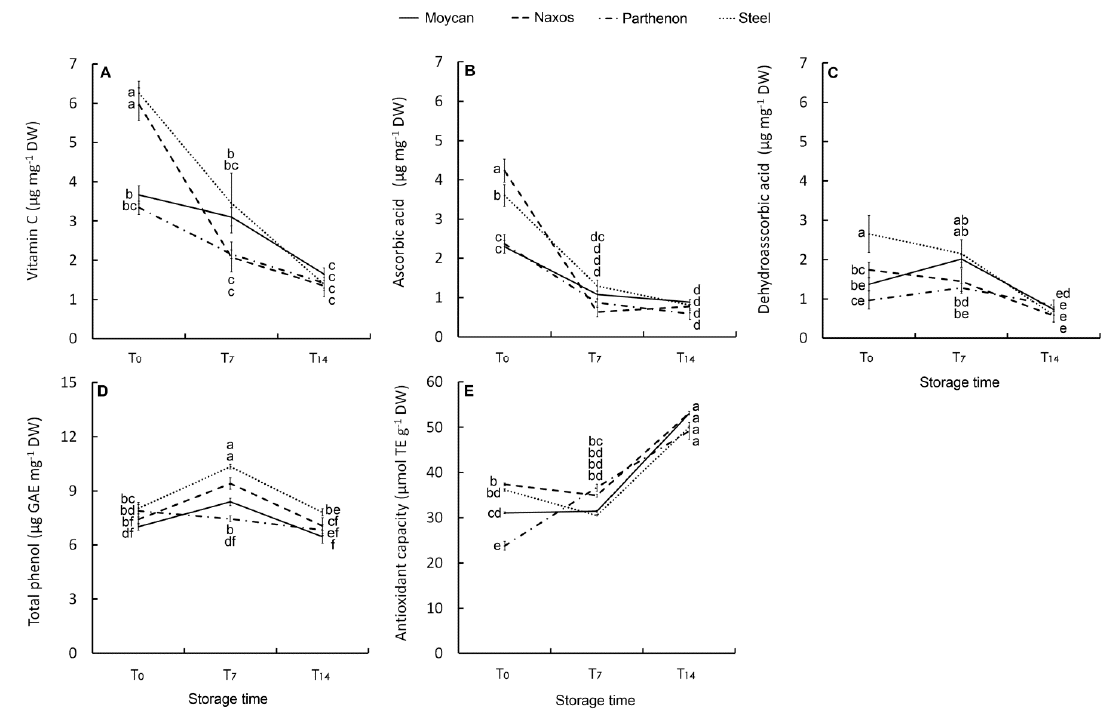
Figure 6. Effect of genotype on vitamin C ( A ), ascorbic acid ( B ), dehydroascorbic acid ( C ), and total phenol concentration ( D ), as well as on antioxidant capacity ( E ) of the raw heads (T 0 ), in 7 days (T 7 ) and 14 days (T 14 ) stored product. Vertical bars (± SE of mean) ( n = 9) with different letters are significantly different according to the Least Significant Difference test ( P = 0.05). GAE = gallic acid equivalent. TE = Trolox equivalent.